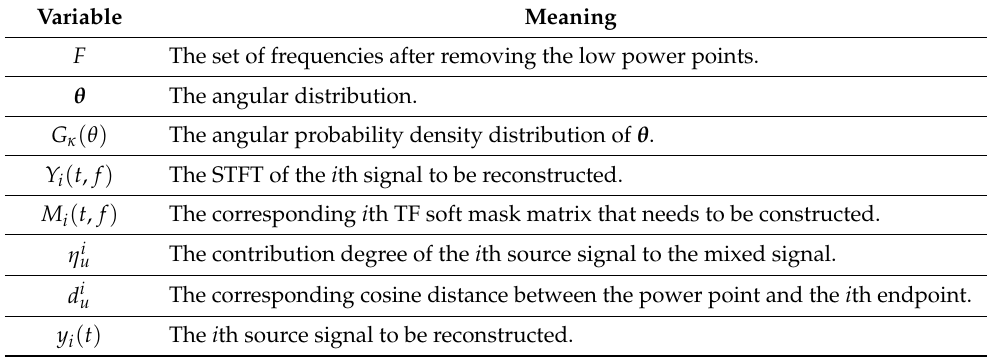
Figure 2. The power scatters of mixed signals with TF aliasing.